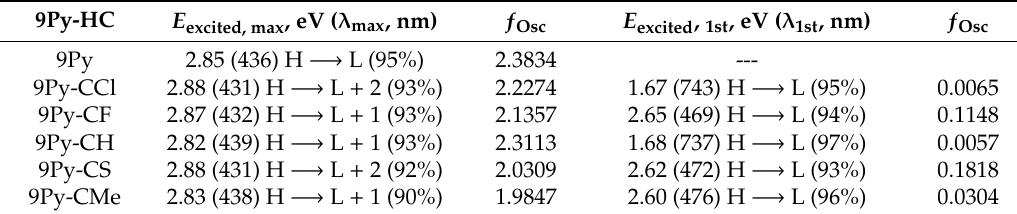
Figure 6. Simulated UV-Vis absorption spectra for 9Py and the 9Py–HC complexes (FWHM = 3000 cm − 1 ). Table 7. Excitation energies for the maximum absorbance ( E excited, max ) and first excited state ( E excited, 1st ), oscillator strengths ( f Osc ) of 9Py-HC. The corresponding main electronic configurations ( > 5%) are also shown.